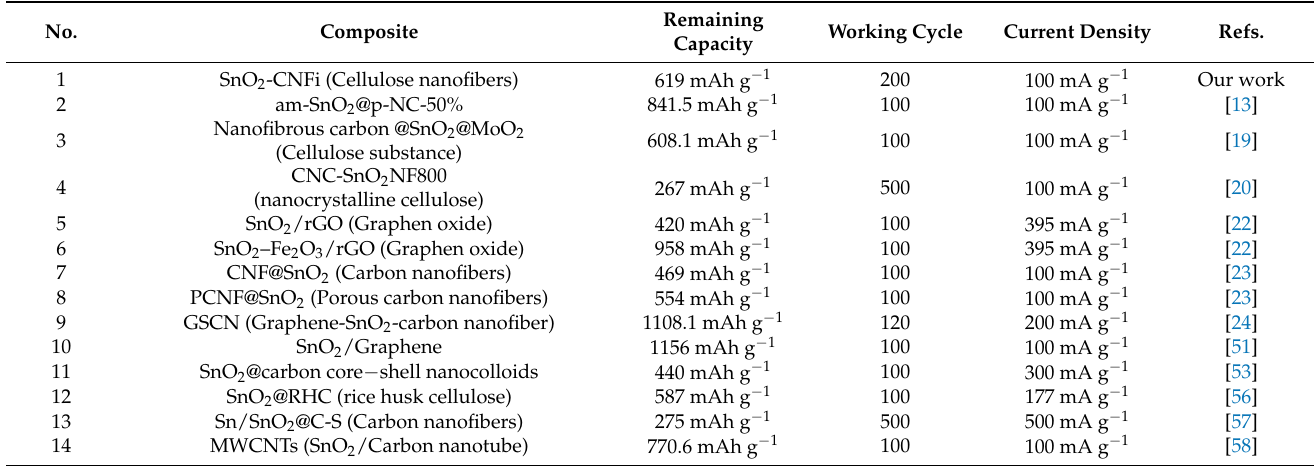
Table 2. Specific capacity summary of previous reports of SnO 2 /carbon materials electrodes.